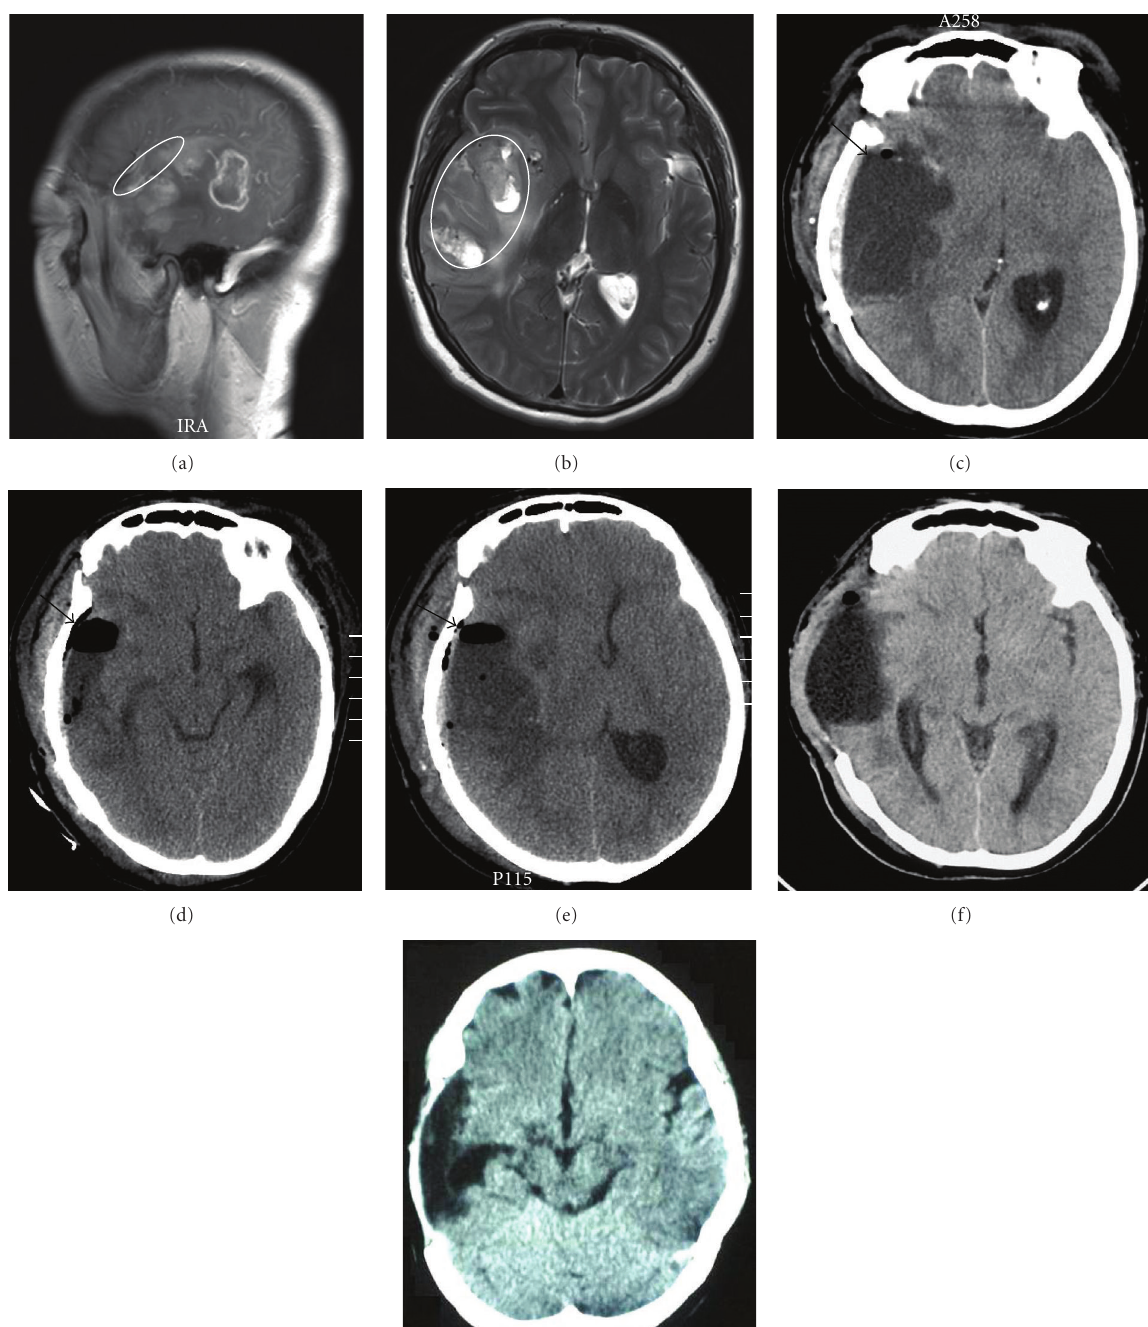
Figure 1: Imaging results for Case 1. (a) Contrast-enhanced MRI showing heterogeneous or ring-like enhancement in the temporal lobe. The elliptical area indicates the cortical incision, via which tumor resection was performed. (b) Axial T2WI showing the tumor resection zone. The cortical tissue located on the surface of the temporal lobe was not resected. (c) CT revealing cyst formation in the tumor resection cavity 3 days after tumor resection. The arrow indicates the position of the “valve”-like structure. (d) Relief of e ff usion in the tumor resection cavity following the reoperation. The arrow indicates the opening of the roof region of the tumor resection cavity and the disappearance of the “valve”-like structure. (e) Recommencement of e ff usion in the tumor resection cavity 5 days after the reoperation. The roof region of the tumor resection cavity was sealed again, indicating possible reformation of the “valve”-like structure. (f) Recommencement of e ff usion in the tumor cavity 1 week after the second reoperation removing the bone flap. (g) Disappearance of cyst formation in the tumor resection cavity 3 months after the second